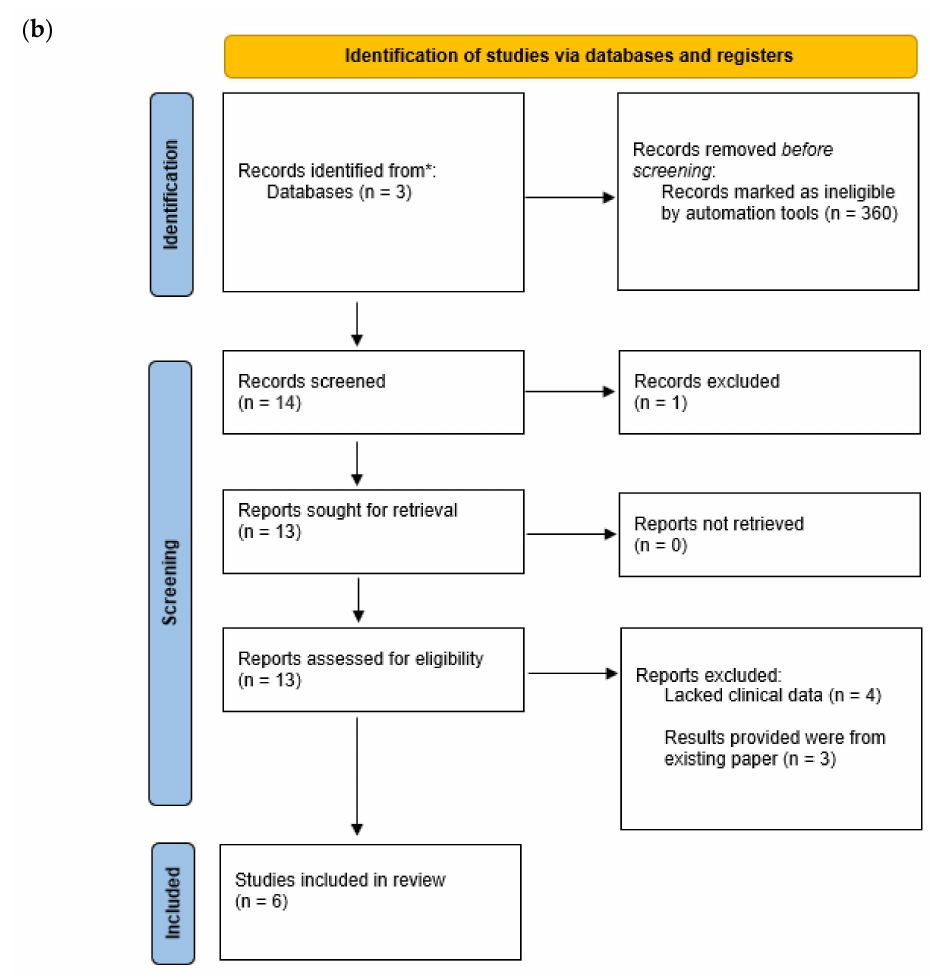
Figure 1. Identification and screening of studies through database and registers. ( a ) Step one of screening. ( b ) step two of screening. * Records identified from databases. ** Records